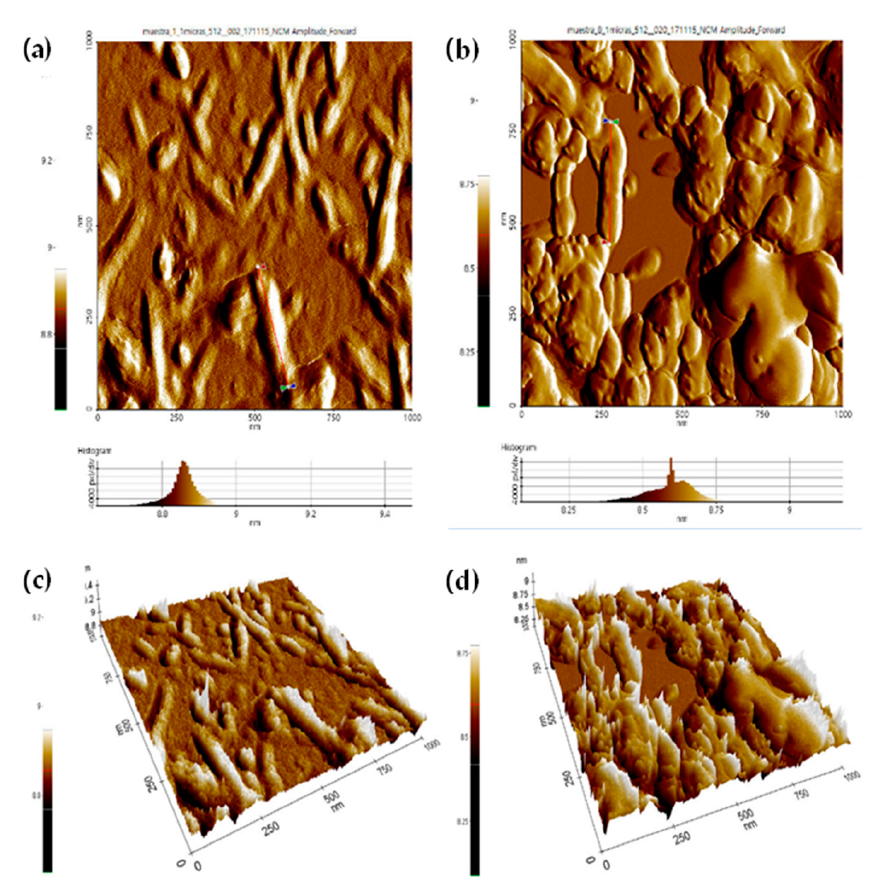
Figure 6. AFM images of CNC-H for two different conditions: ( a ) 2D image and histogram of E1H, ( b ) 2D image and histogram of E8H, ( c ) 3D image of E1H, ( d ) 3D image of E8H. For the rest of the CNC-H samples, L diminishes as HCl concentration increases, with a minimum and maximum L value of 143 and 1100 nm, respectively. In the case of the width, most of the samples exhibit W values between 52 and 320 nm, and H values of 8.6 and 9.1 nm. The L/H ratios for CNC-H obtained with 2N HCl tend to increase with temperature and time, with values ranging from 20 to 98 nm, whereas L/H aspect ratio values for 8N HCl are in the range of 30 to 40, except for the E2H sample. Finally, L/W ratios are between 2.5 to 20, which have a broader range of values due to the different sizes obtained for the CNC-H. The complete set of AFM images of CNC-H are shown in Figure S3 and the average dimensions obtained at different concentrations, temperatures, and hydrolysis times, as well as aspect ratios, are presented in Table S4. A comparison of CNC-H with different raw materials is shown in Table 5. To our knowledge, there is no information regarding the production of CNC-H from A. tequilana Weber var. Azul. The L/D aspect ratio reported in this table is based on the CNC-H height (L/H). When W and H values are similar, CNC have a cylindrical shape with a circular cross-section. However, our results showed that the cross-section of the nanocrystals is wider than higher, which may correspond to an ellipsoidal shape. In some samples, different W were observed due to the agglomeration of the deposited CNC, but only not- aggregated CNC-H were selected to study L, W, and H measurements. The low stability and agglomeration of CNC-H are expected due to the absence of groups on the surface of these nanocrystals